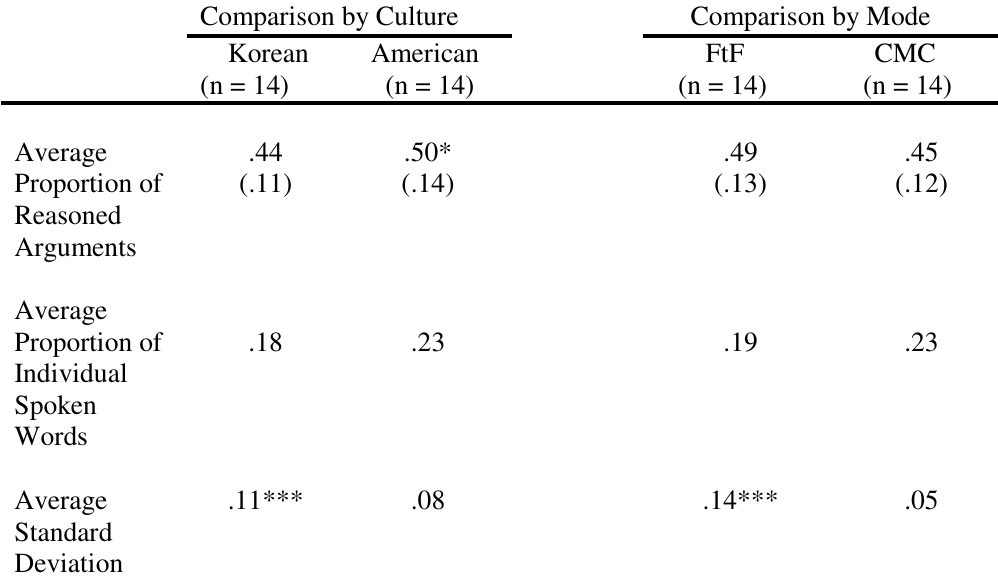
Table 3. Average Proportion of Reasoned Arguments, Average Proportion of Individual Spoken Words, Average Standard Deviation by Culture and